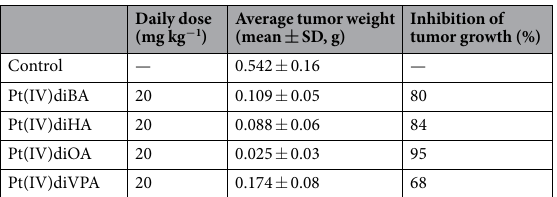
For the assessment of the adverse side effects, changes in the body weights of tumor-bearing mice were moni- tored daily over the course of 15 days. The time course of body weight changes (Supplementary Fig. S1) confirmed that treatment with all Pt(IV) complexes did not induce significant adverse effects (body weight loss was lower than 20%), including body weight loss throughout the therapeutic experiment. It was previously shown for a similar series of dicarboxylato Pt(IV) compounds that organic chains of inter- mediate length offer the best compromise between lipophilicity and water solubility for oral administration 36 . To better understand the biodistribution properties of the Pt(IV) complexes containing axial aliphatic chains following their administration by oral gavage, tissue samples were collected from LLC-bearing mice treated with a single dose of Pt(IV)diOA and Pt(IV)diVPA and analyzed for platinum content. The details of these experiments and their results are described in the Supplementary material and Supplementary Fig. S2. Platinum concentra- tions in blood of the mice treated with both Pt(IV)diOA and Pt(IV)diVPA were modest (around 0.5 μ g Pt mL − 1 of whole blood) and slightly higher in the blood of mice treated with Pt(IV)diOA for a longer time of treatment (4 h). Further, the contents of platinum in tissues of the mice treated with both Pt(IV)diOA and Pt(IV)diVPA were similar, and the highest platinum concentrations were found in liver followed by tumor tissue and kidney.